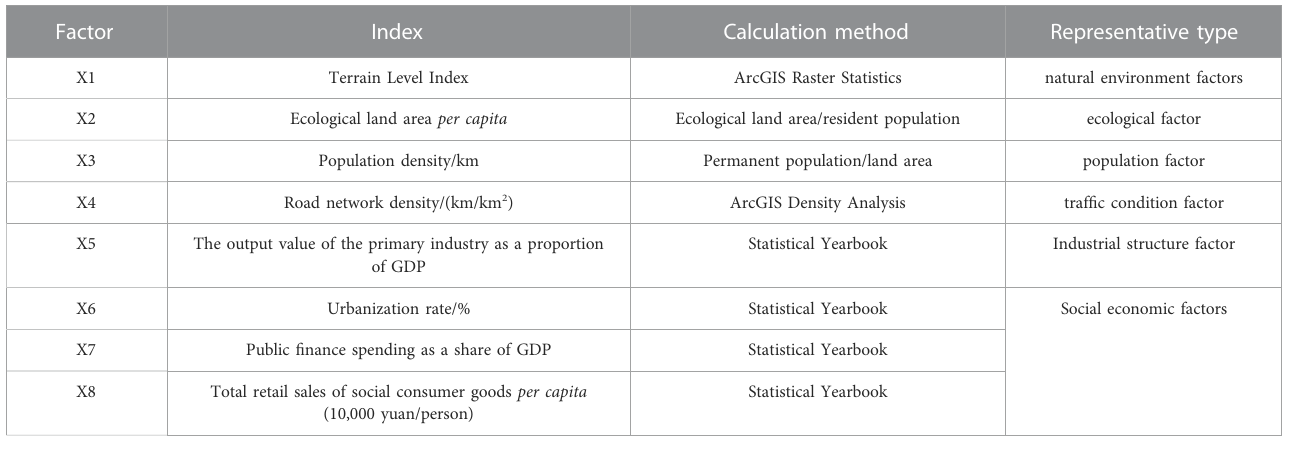
TABLE 2 Geographic Detection factor indicators.